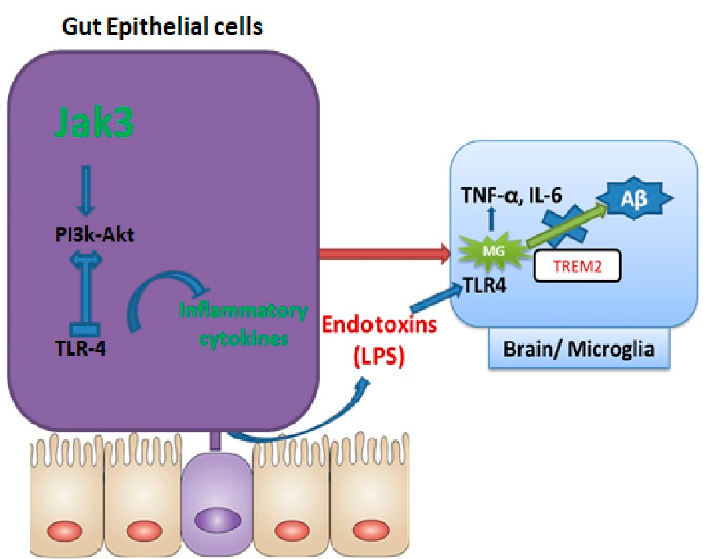
Figure 10. Model for Jak3 signaling in gut–brain axis. Conserved Jak3-mediated signaling in intestinal epithelial cells and microglial cells in the brain are shown.